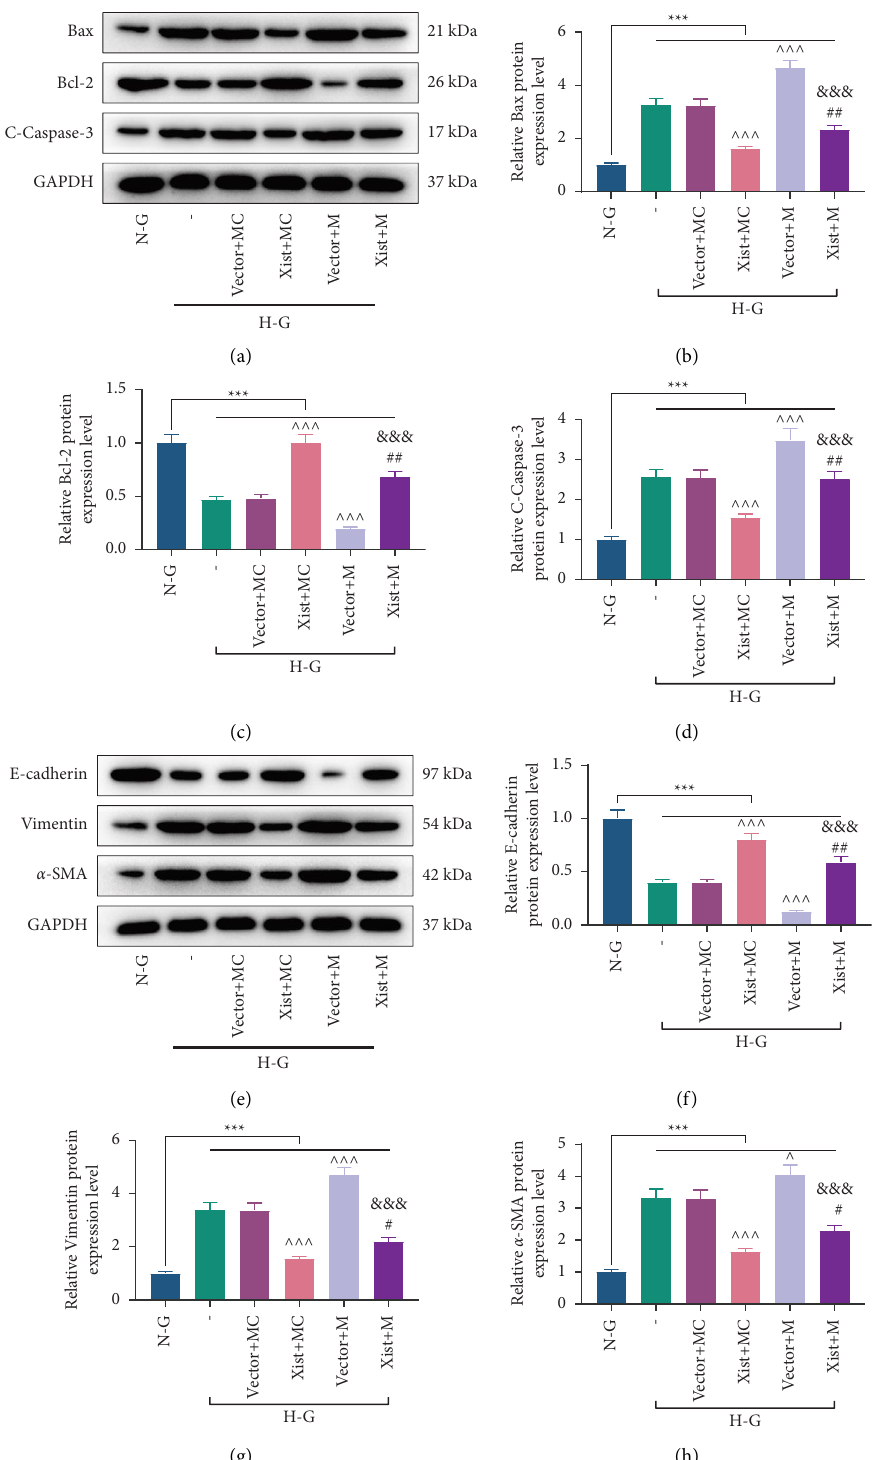
Figure 4: XIST targeted miR-30d-5p to regulate apoptosis- and EMT-related proteins in HG-induced podocytes. Te experiments were divided into six groups. Te frst two groups of MPC5 cells were treated with NG or HG. Te last four groups of MPC5 cells cotransfected with XIST overexpression plasmid/empty vector and miR-30d-5p mimic/mimic control were treated with HG. (a–d) Te expressions of apoptosis-related proteins (Bax, Bcl-2, and cleaved caspase-3) in MPC5 cells were determined by Western blot. GAPDH was used as the internal control. (e–h) Te expressions of EMT-related proteins (E-cadherin, Vimentin, and α -SMA) in MPC5 cells were determined by Western blot. GAPDH was used as the internal control. Quantifed values were presented as mean ± standard deviation of at least three independent experiments. ∧ p < 0 . 05, ∧∧∧ p < 0 . 001 vs. vector+MC. # p < 0 . 05, ## p < 0 . 01, ### p < 0 . 001 vs. XIST+MC. && p < 0 . 01, &&& p < 0 . 001 vs. vector+M. HG: high glucose. NG: normal glucose. M: mimic. MC: mimic control. EMT: epithelial-mesenchymal transition. GAPDH: glyceraldehyde-3-phosphate dehydrogenase; XIST: X inactive specifc